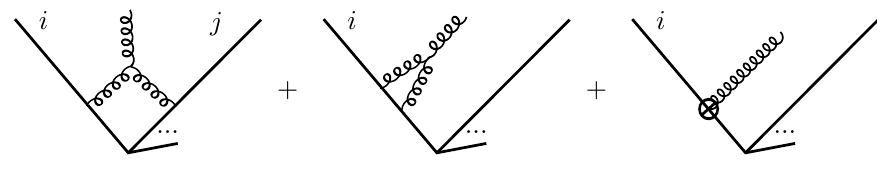
Figure 6 . Second building block: one-loop soft